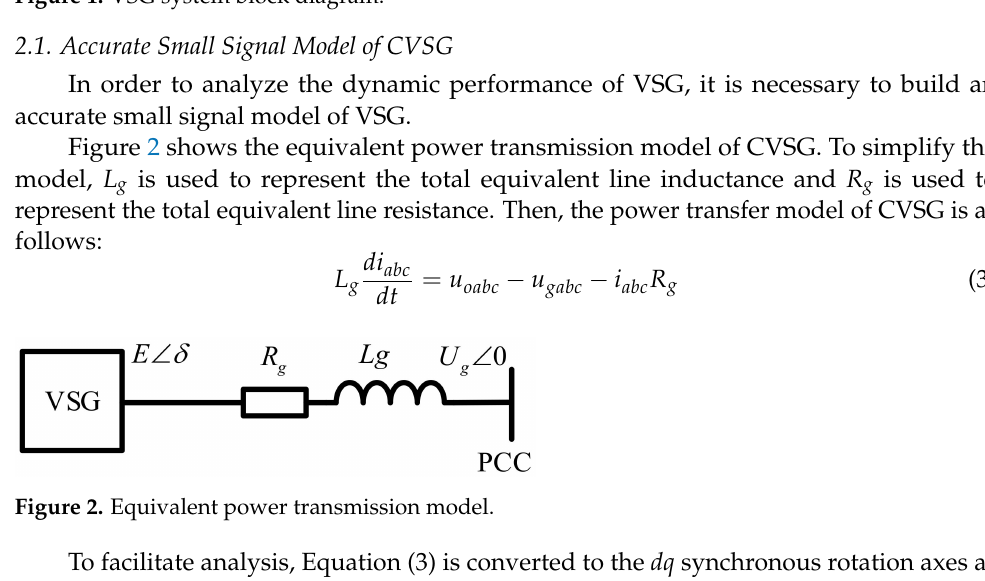
Figure 1. VSG system block diagram.